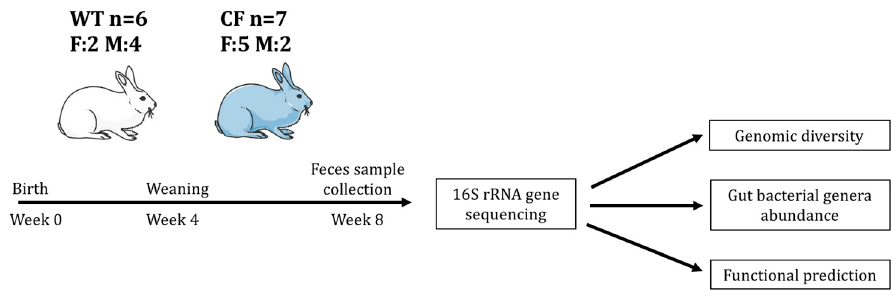
Figure 1. Illustration of experimental flow. F: female. M: male.